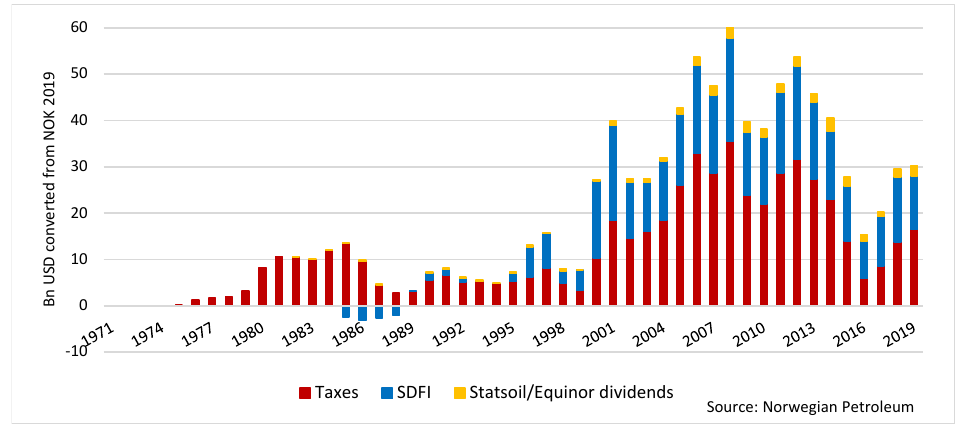
Figure 1. The Norwegian government’s net cash flow from petroleum activities.